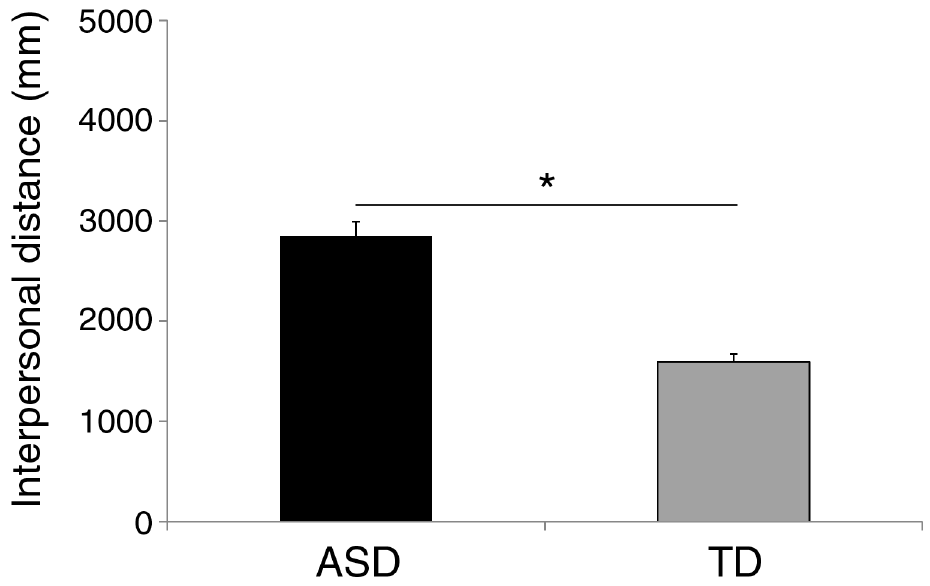
Figure 2. Mean preferred distance from the confederate in children with autism spectrum disorders (ASD), and children with typical development (TD). Asterisk indicates significant comparison (p < 0.05). Error bars denote s.e.m. doi: